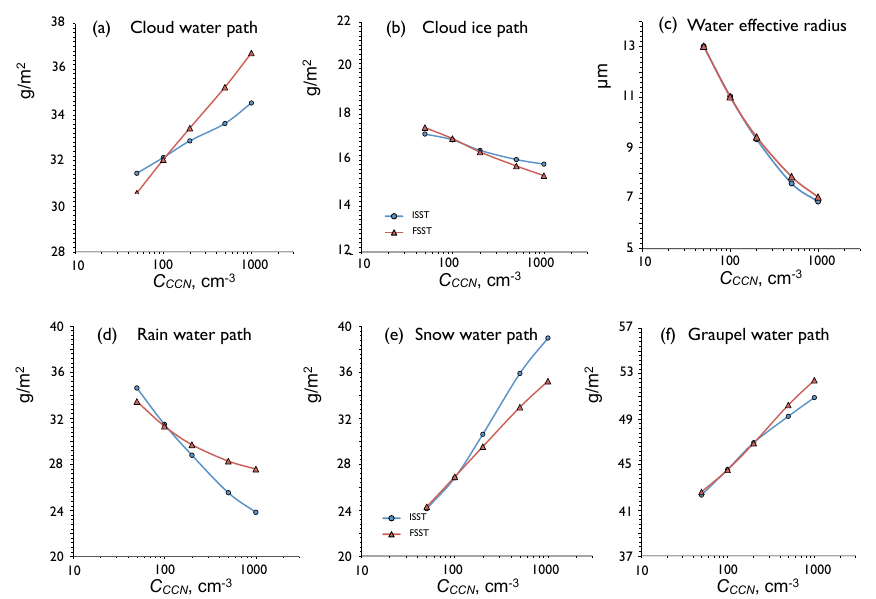
Fig. 5. Dependence of column-integrated (a) liquid cloud water, (b) cloud ice, (d) rain water, (e) snow water, (f) graupel water and of (c) liquid effective radius on CCN number concentration at 1% supersaturation in simulations with fixed (red) and interactive (blue)